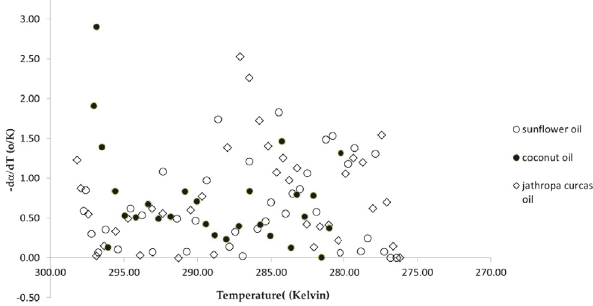
Figure 4: Sunflower oil contact angle vs. temperature.